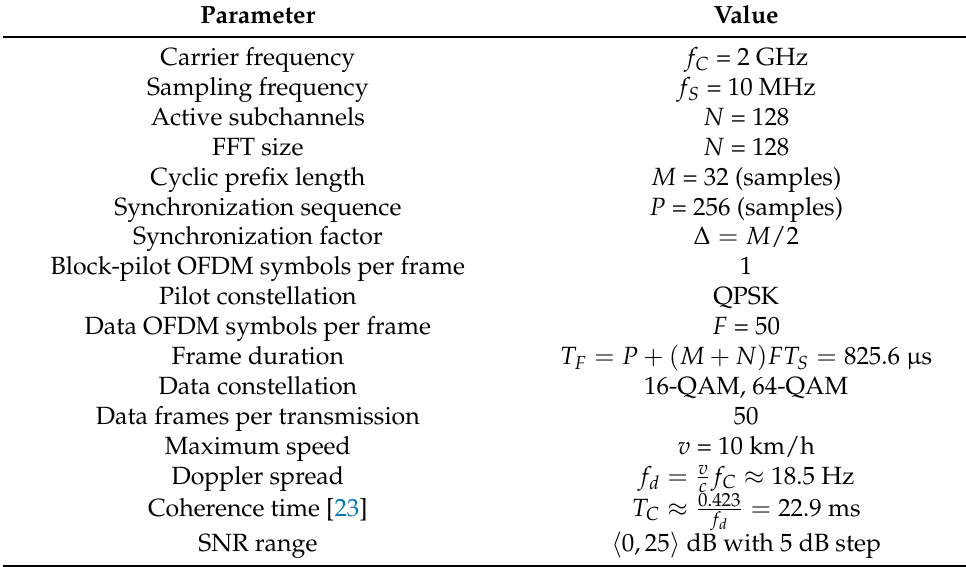
Table 2. System model